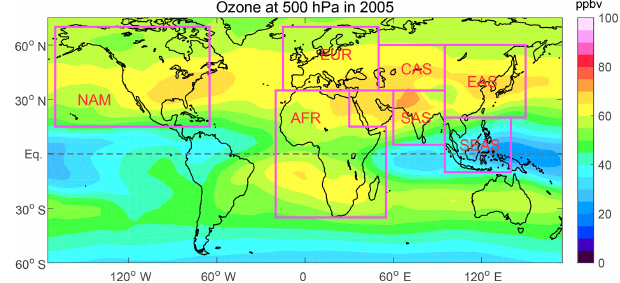
Figure 1. Annual mean ozone concentrations in the middle tro- posphere (500hPa) in 2005 from GEOS-Chem simulations. The magenta boxed areas define seven regions, plus the rest of the world (ROW, all regions except the boxed regions). The seven re- gions include East Asia (EAS; 20–60 ◦ N, 95–150 ◦ E), North Amer- ica (NAM; 15–70 ◦ N, 170–65 ◦ W), Europe (EUR; 35–70 ◦ N, 15– 50 ◦ E), Africa (AFR; 0–35 ◦ N, 20 ◦ W–30 ◦ E and 35 ◦ S–0, 20 ◦ W– 55 ◦ E), central Asia (CAS; 35–60 ◦ N, 50–95 ◦ E), South Asia (SAS; 5–35 ◦ N, 60–95 ◦ E), and South-east Asia (SEAS; 10 ◦ S–20 ◦ N, 95– 140 ◦